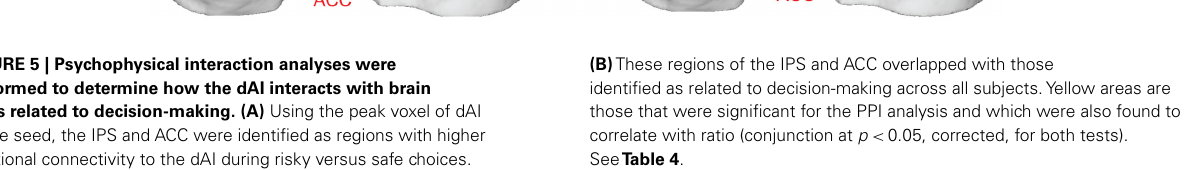
Table 4 | Regions with high functional connectivity with the left dAI as seed region. Region Peak voxel L/R T 17 x y Middle frontal gyrus